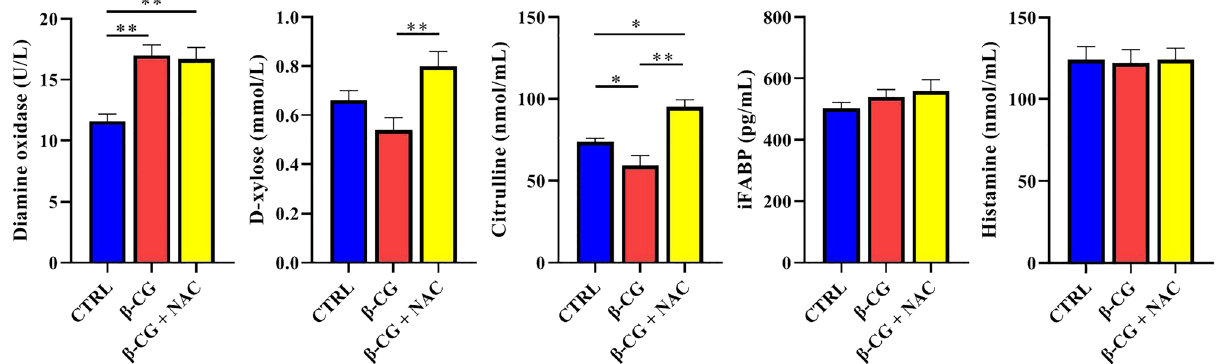
Figure 2. Measurement of plasma indices in piglets. D-xylose and diamine oxidase in plasma were determined by using commercially available kits. Concentrations of histamine and citrulline in plasma were determined by high-performance liquid chromatography. Level of iFABP in the plasma was measured by using an iFABP ELISA kit. Data are means ± SEM, n = 8. * P < 0.05, ** P <